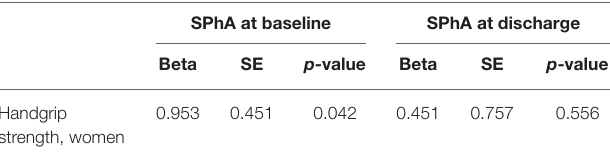
TABLE 3 | Multivariate linear regression analysis with HGS following adjustments for age and HGS before kidney transplantation. SPhA at